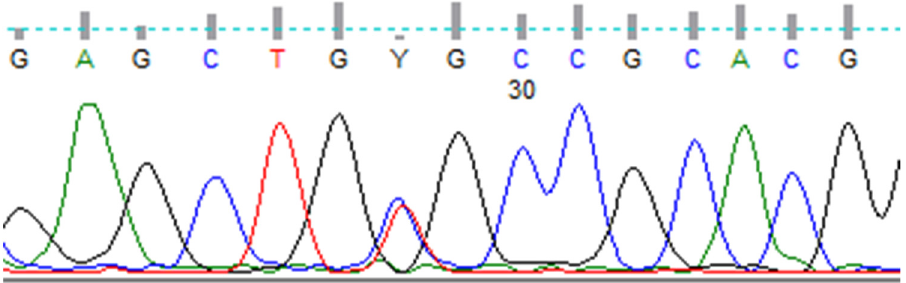
Figure 1. Sanger sequencing of codon 634 of RET showing p.(Cys634Arg) c.1900T>C mutation.